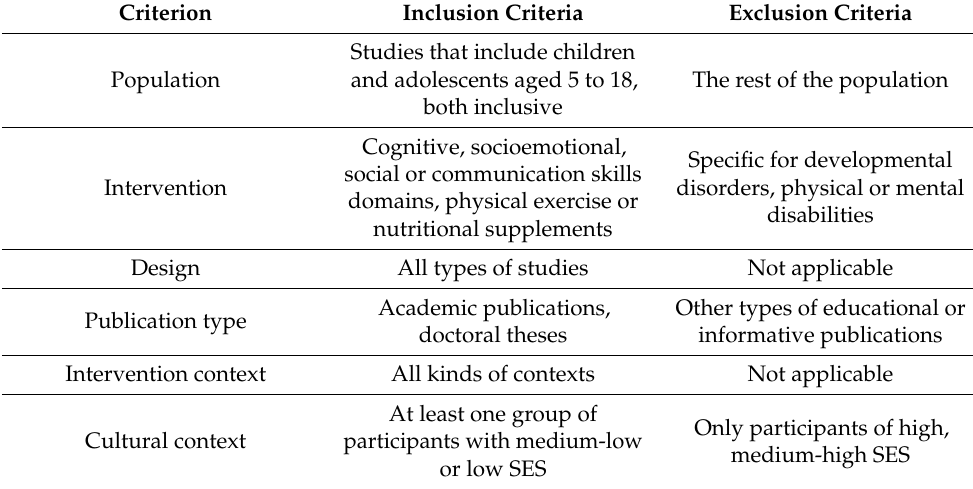
Table 1. Inclusion and exclusion